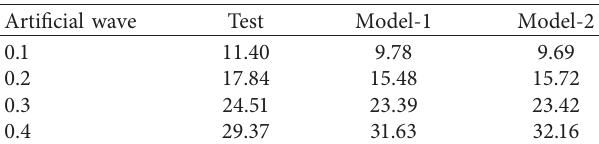
Figure 11: Time-history curves of relative displacement of the top end of the insulator at Table 8: Comparison of peak stresses at the root of the bushing obtained by the test and simulation.